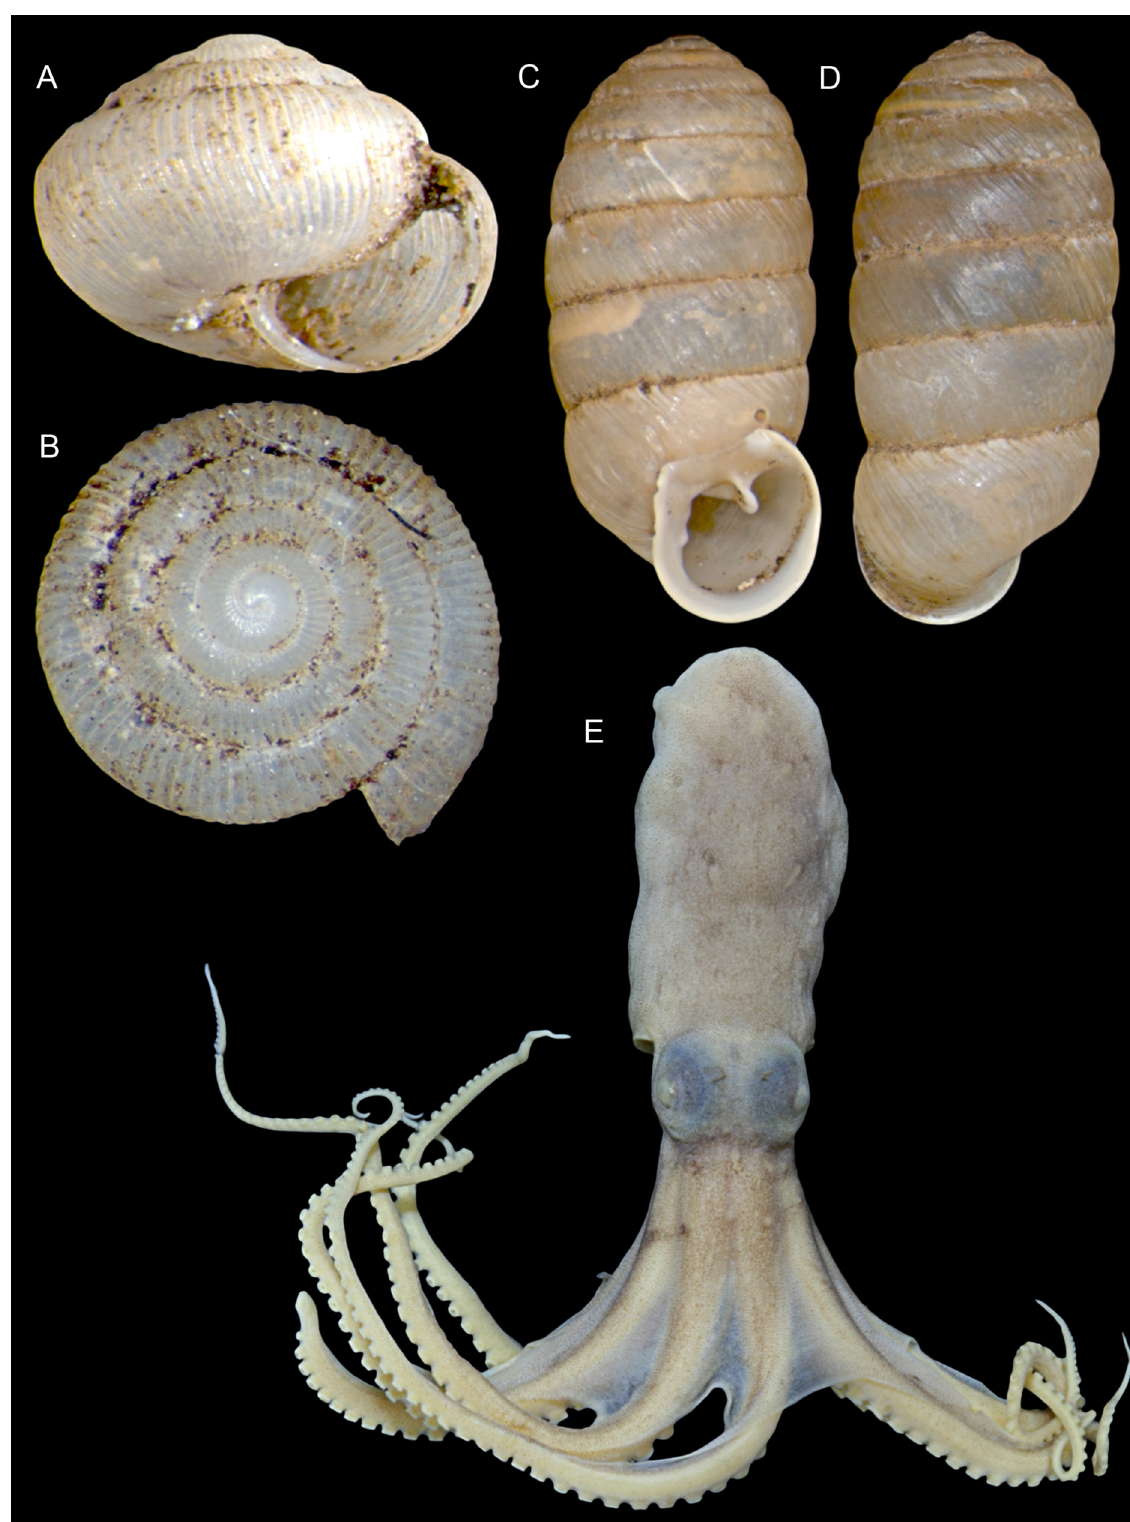
Fig. 7. A–B . Teracharopa goudi Maassen, 2000, probable paratype MZSP 95494, L = 2 mm, W = 2.7 mm. C–D . Orculella astirakiensis Gittenberger & Hausdorf, 2004, paratype MZSP 95489, L = 8.3 mm, W = 4